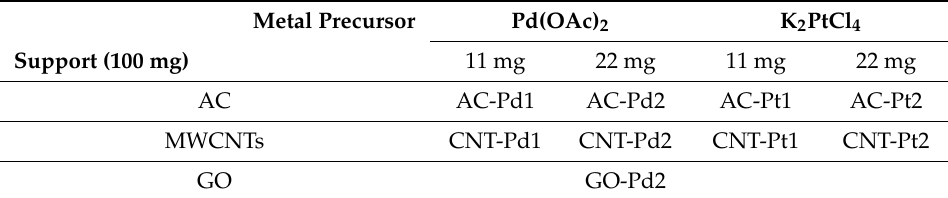
Table 1. Denotation of the prepared composites.